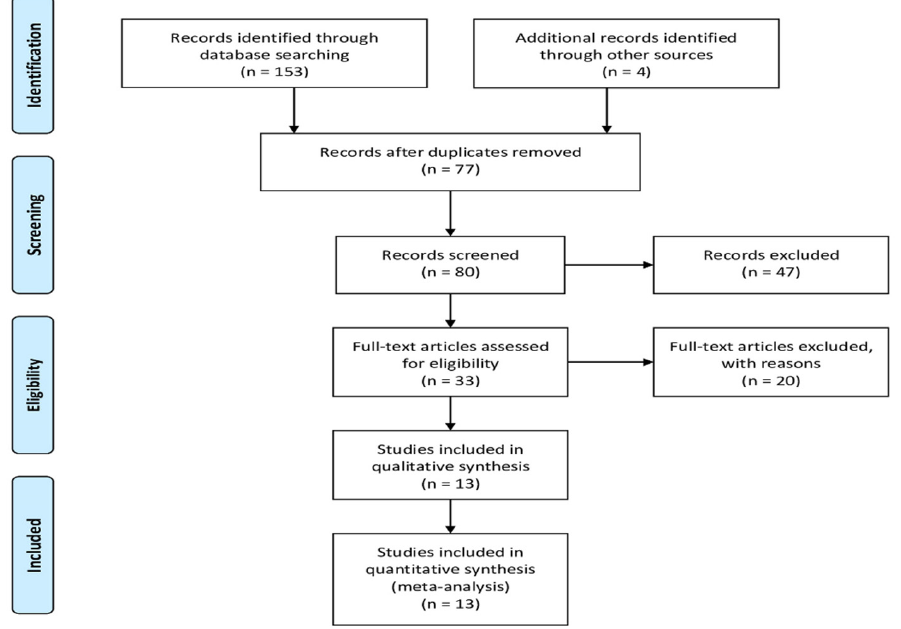
Figure 1. A PRISMA flowchart of the literature search strategy used in our meta-analysis and systemic review.